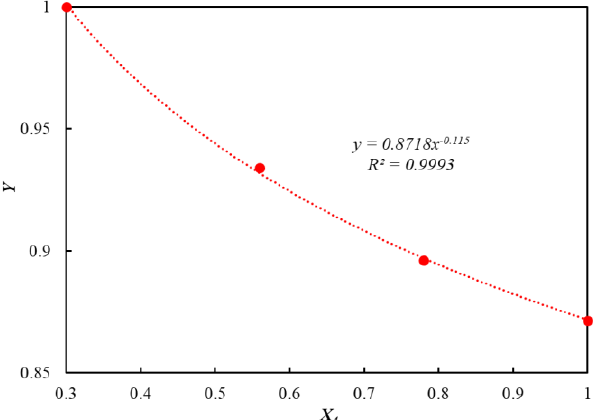
Figure 12. The influence of the thickness of casing and cement on downhole perforation peak pressure.